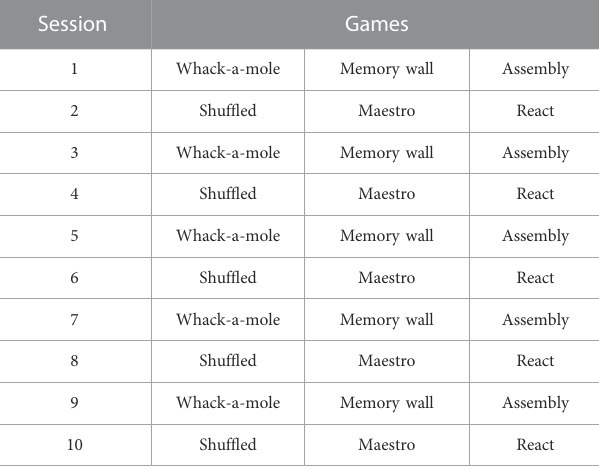
TABLE 1 Sequence of games played in the various